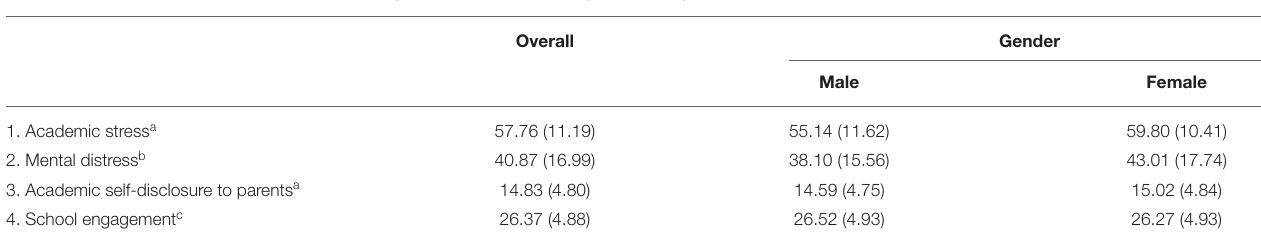
TABLE 1 | Descriptive statistics of the research variables. Means and standard deviations for each scale (standard deviations in parenthesis)